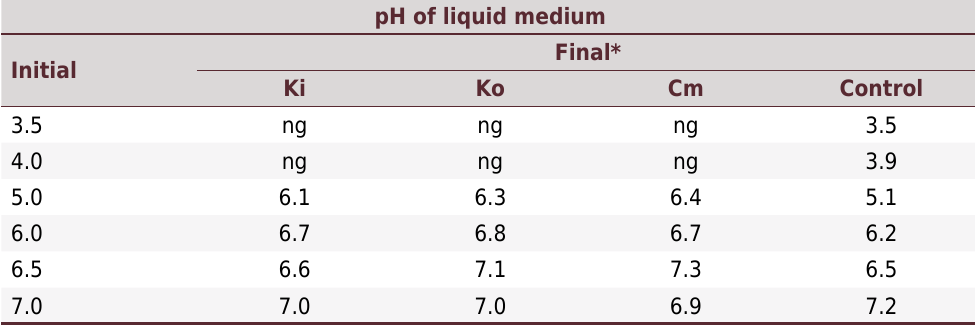
Table 2. Changes of pH in Luria-Bertani culture medium (LB) supplemented with 300 mg kg -1 Pb 2+ by metal-resistant